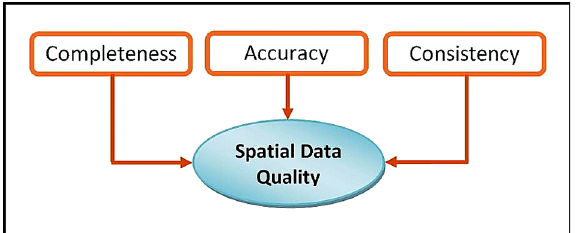
Fig. 1. Data quality